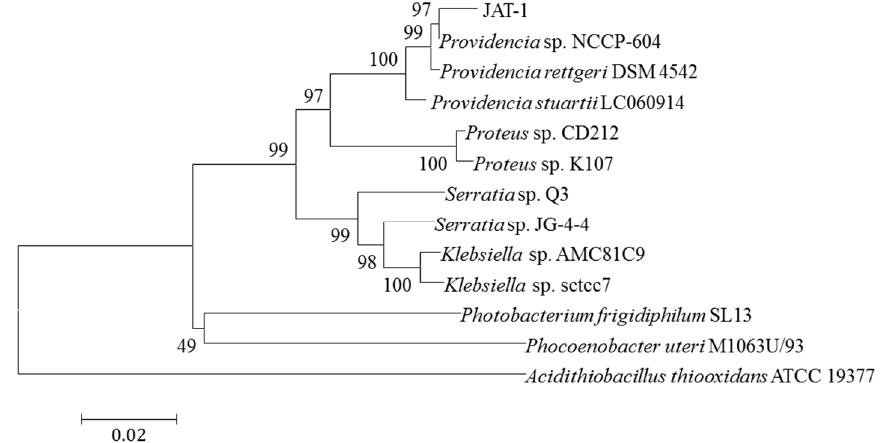
Figure 2. Phylogenetic tree of JAT-1 based on 16S rRNA sequences with the most similar sequences retrieved from National Center for Biotechnology Information (NCBI) database. The scale bar indicates 0.02 changes per nucleotide. Numbers at nodes represent bootstrap values in 1000 times resampling analysis.